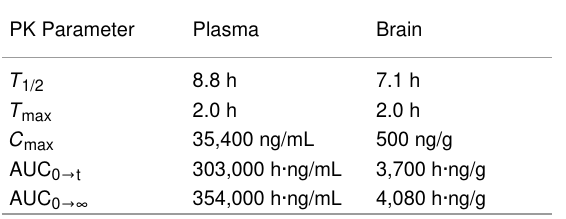
Table 1: Mouse pharmacokinetic data for 1 ; oral (p.o.) dose at 10 mg/kg.